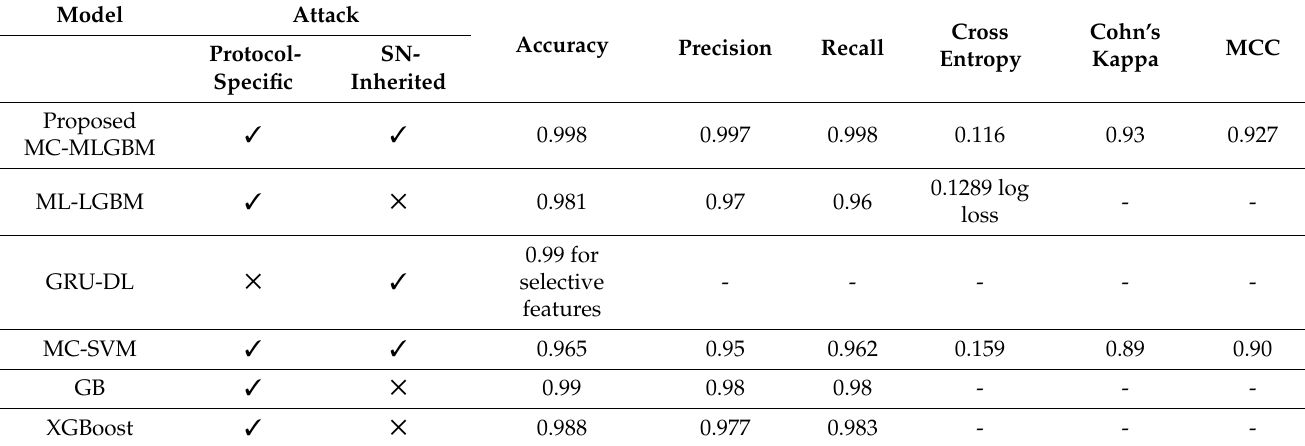
Table 4. Performance Analysis of the Proposed Model.